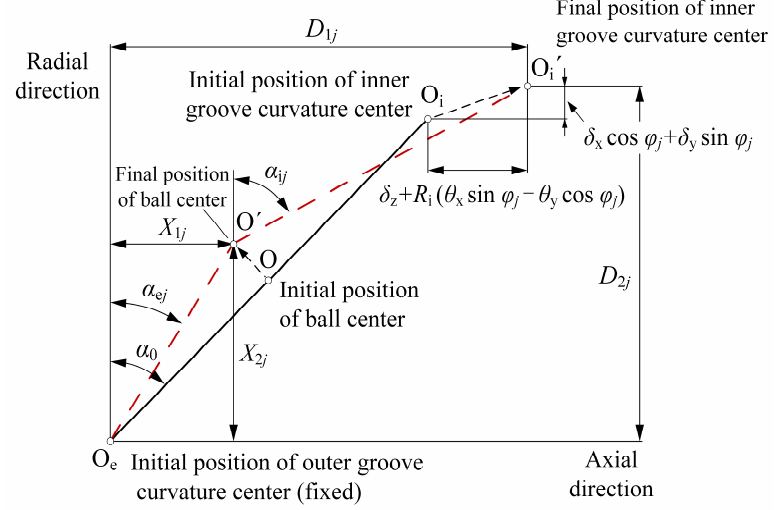
Figure 3. Positions of ball centers and raceway groove curvature centers.